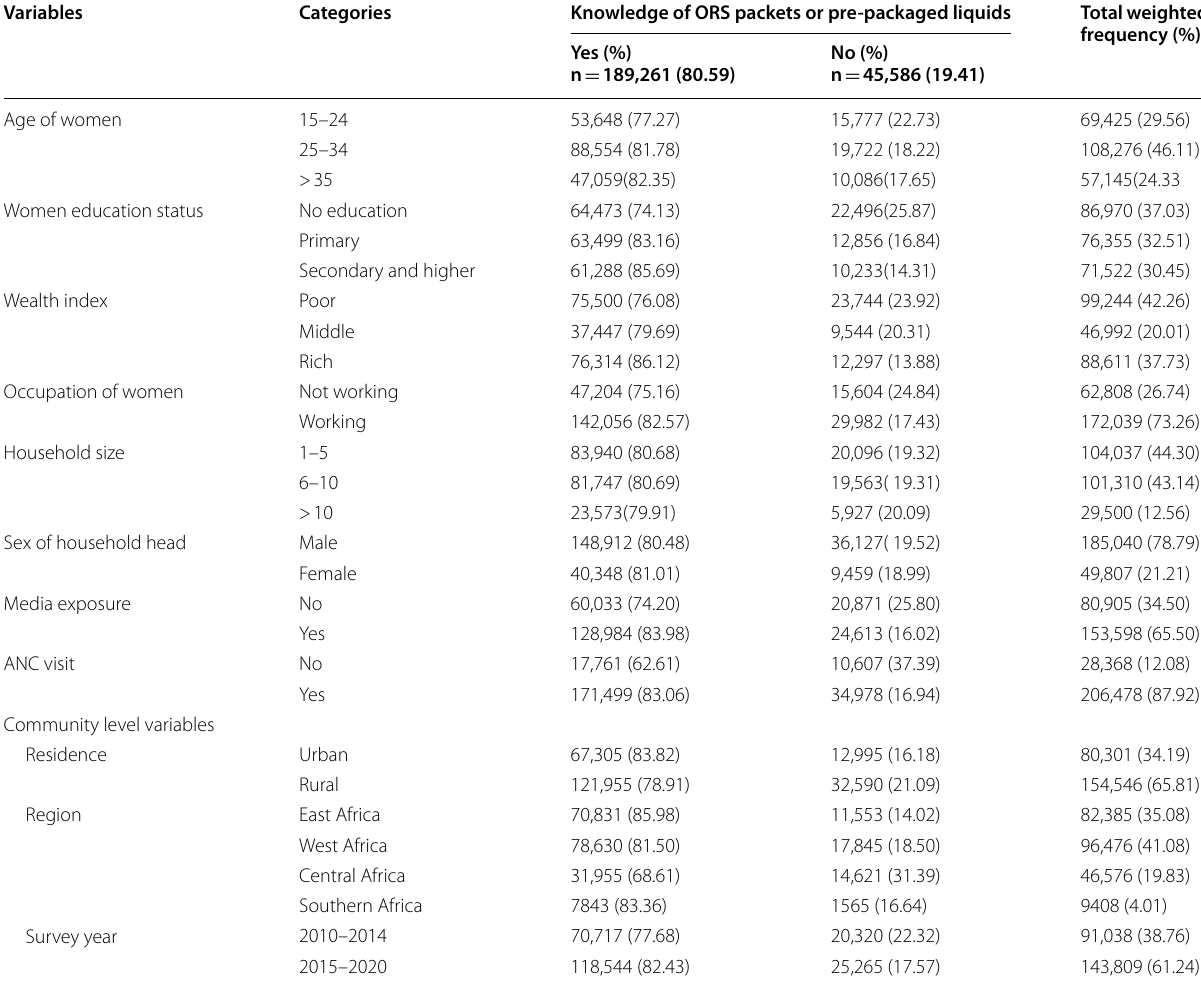
Table 2 Knowledge of ORS packets or pre-packaged liquids for the management of diarrhea across variables among women of